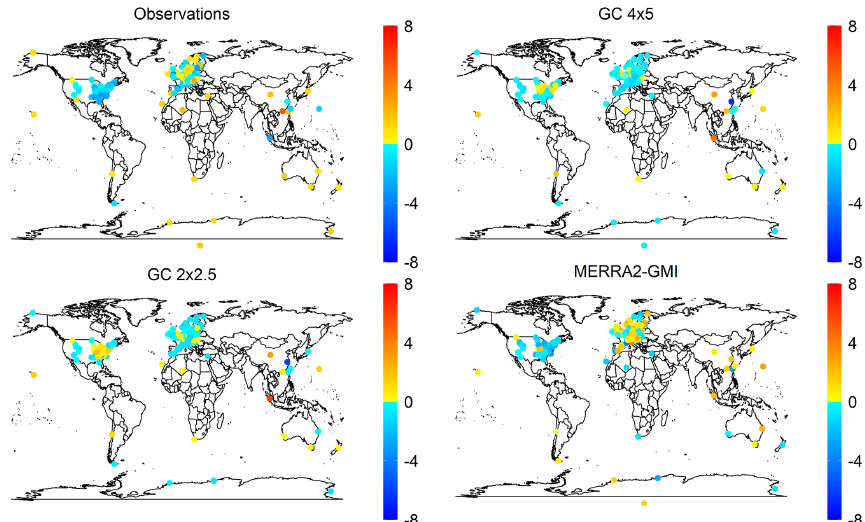
Figure 9. Decadal trends (ppb per decade at surface locations in TOAR-compiled observations, GC 4 × 5, GC 2 × 2 . 5, and MERRA2-GMI. GC 4 × 5 refers to the GEOS-Chem v12.9.3 simulations at the 4 ◦ × 5 ◦ horizontal resolution, GC 2 × 2 . 5 is the same model at 2 ◦ × 2 . 5 ◦ , and MERRA2-GMI refers to the NASA GEOS GMI at ∼ 50km. Increases are shown in shades of red, and decreases are shown in shades of blue.